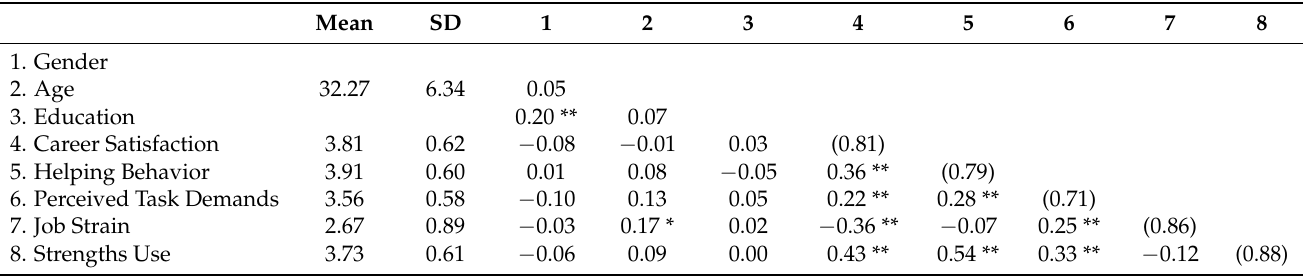
Table 2. Means, standard deviations, and